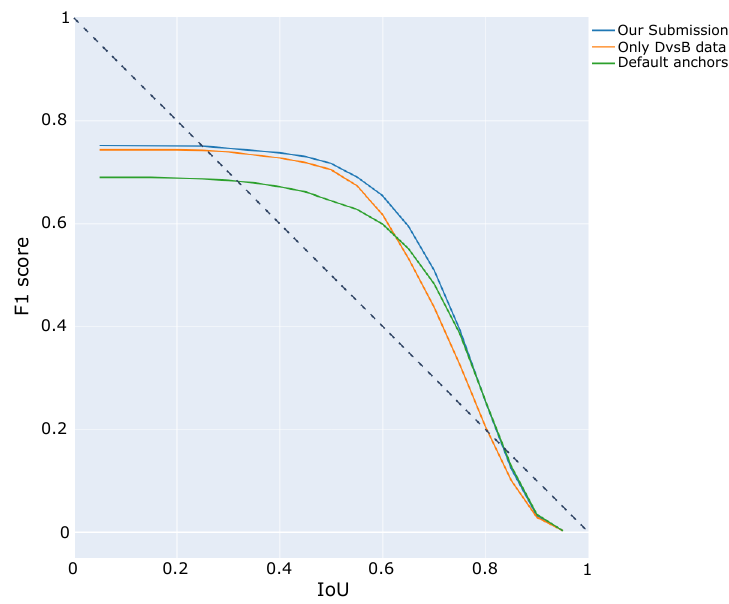
Figure 10. F1 score result for different IoU